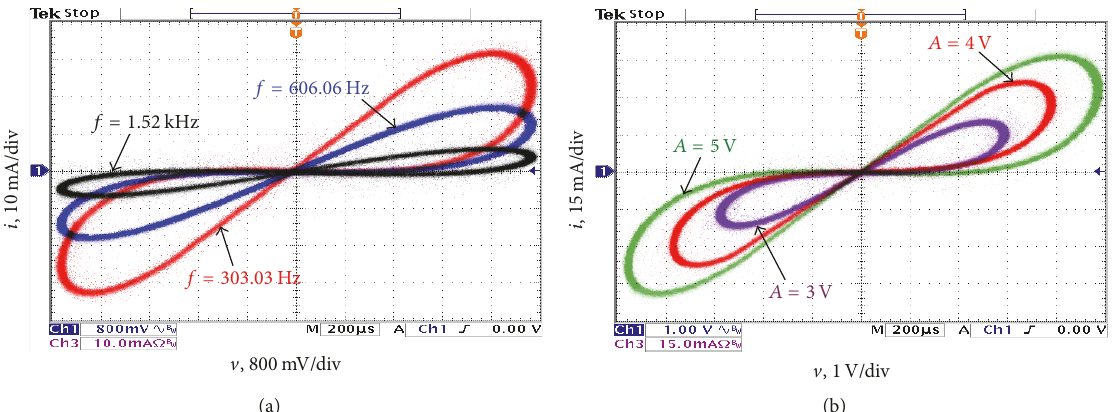
Figure 11: Experimentally measured pinched hysteresis loops of the memristor emulator. (a) 𝐴 = 4V with different frequencies. (b) 𝑓 = 303.03 Hz with different amplitudes.